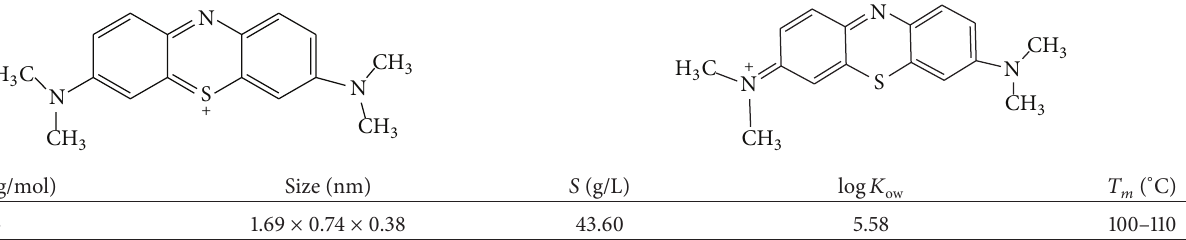
Table 1: Resonance structure and some important physical properties of MB (3, 7-bis(dimethyl amino)phenothiazine-5-ium chloride)